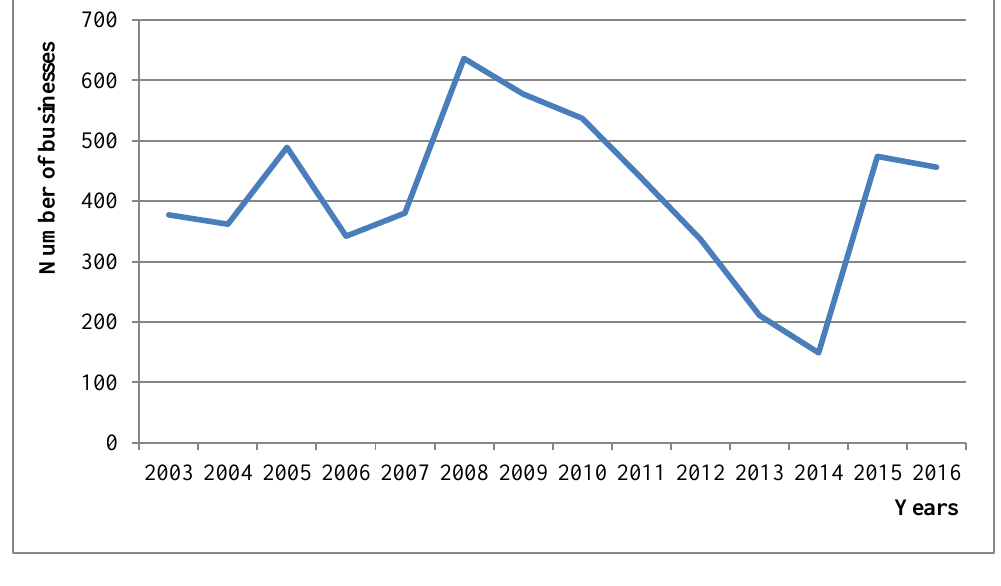
Fig. 3. Number of businesses with foreign capital registered by